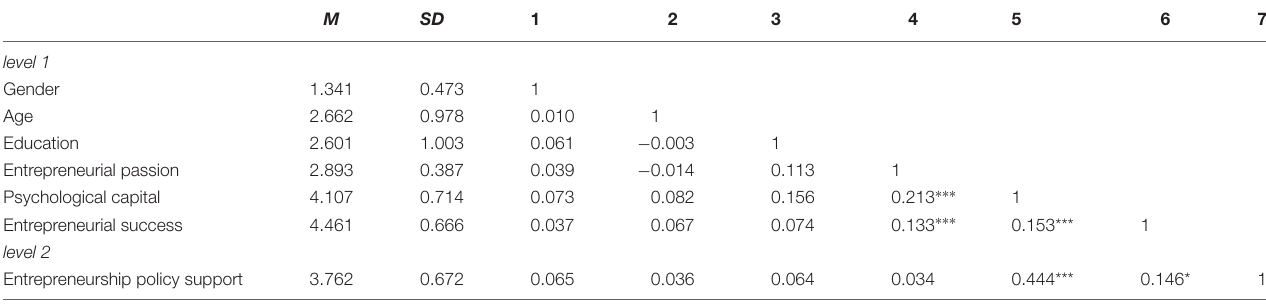
TABLE 2 | Means, standard deviations, and correlations among the variables. M SD